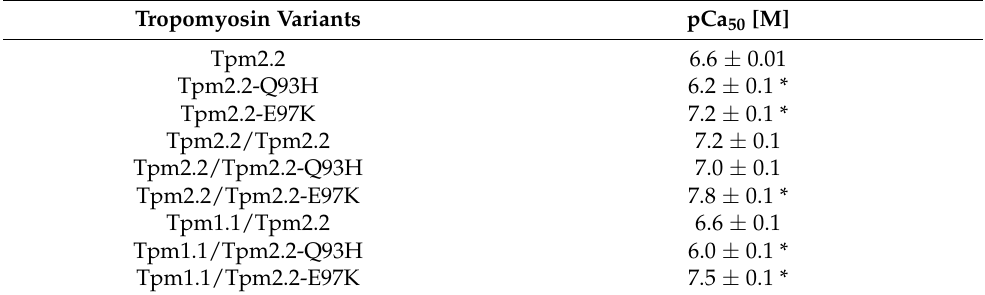
Figure 7. Sensitivity of the actin filaments to increasing [Ca 2+ ]. Actomyosin ATPase activity in the presence of Tpm2.2 homodimers ( A ), crosslinked Tpm2.2/Tpm2.2 heterodimers ( B ), and crosslinked Tpm1.1/2.2 heterodimers ( C ). The symbols are: actomyosin S1 ATPase regulation by Tpm2.2 (black circles), Tpm2.2-Q93H (red triangles), and Tpm2.2-E97K (green squares) in complex with troponin. The lines were generated by fitting the experimental points to the Hill equation (Equation (3)). Protein concentrations: 5 µ M F-actin, 1 µ M myosin S1, 0.6 µ M tropomyosin, and 1.0 µ M Tn. Other conditions as in Figure 6 legend. Table 2. Sensitivity of tropomyosin-troponin-regulated myosin S1 ATPase to Ca 2+